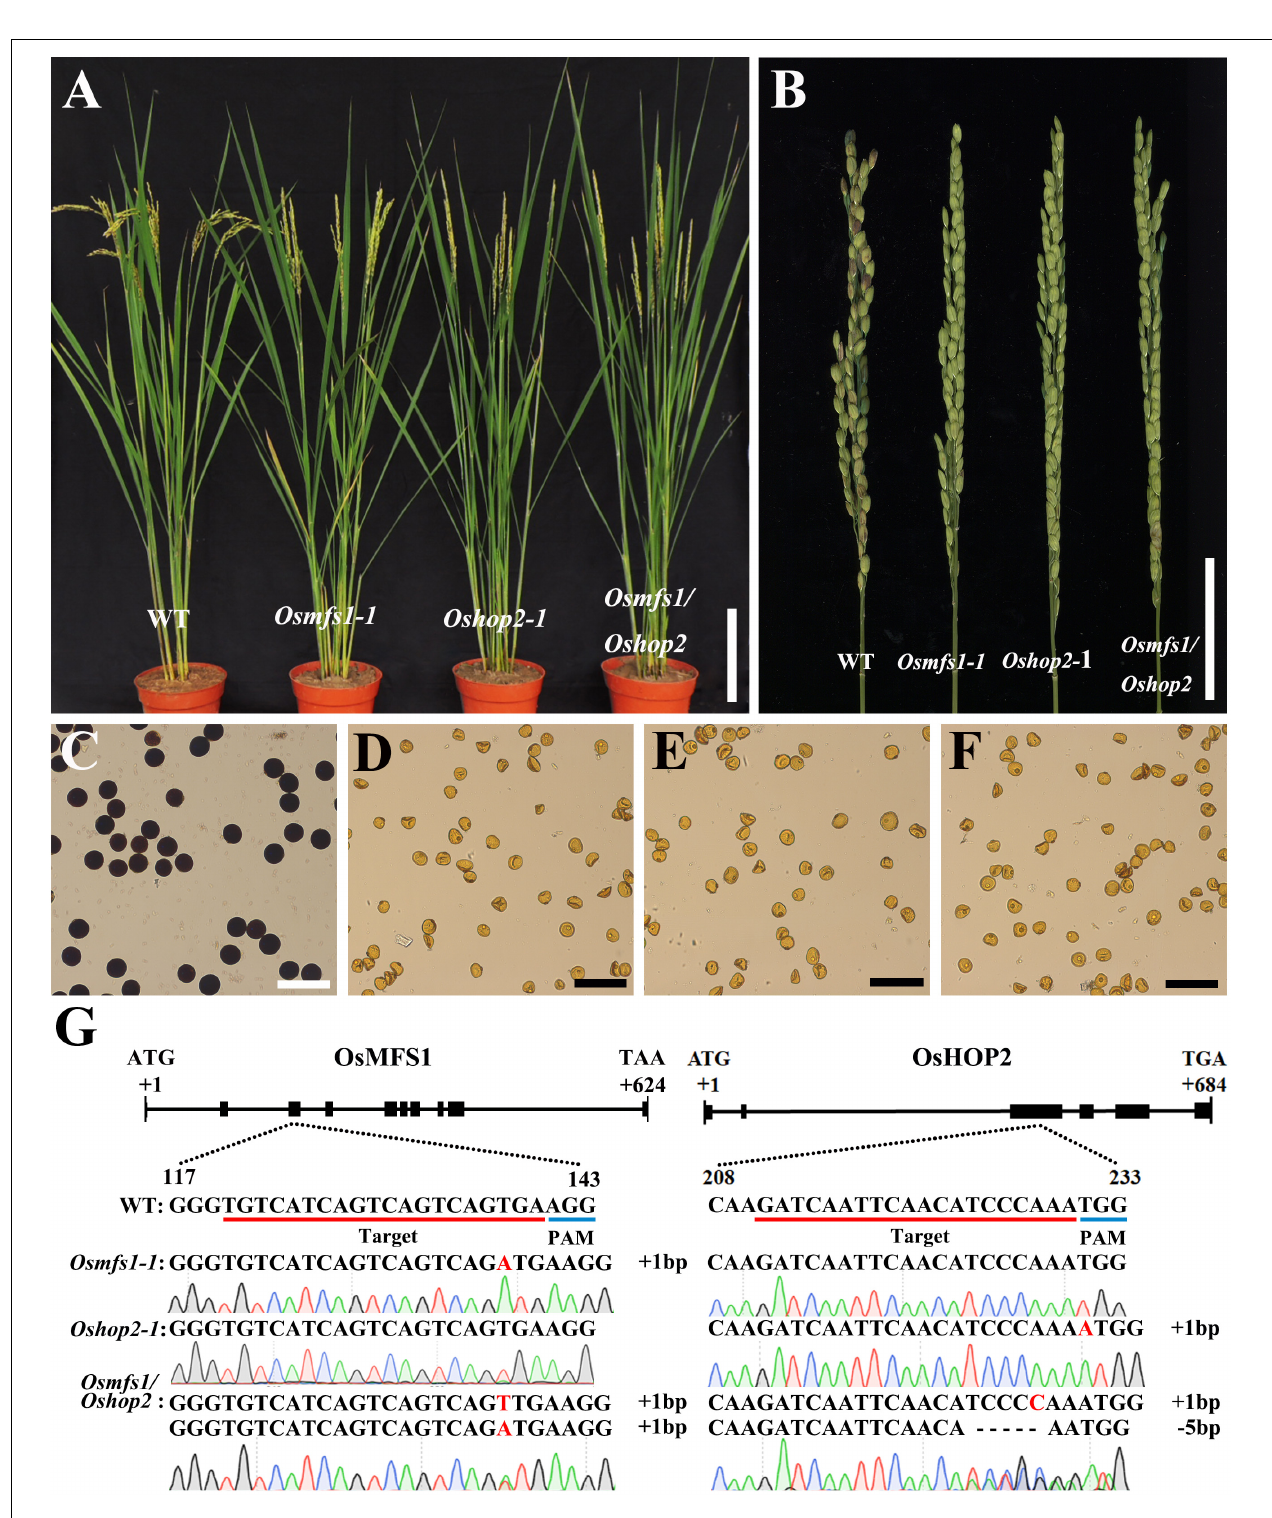
FIGURE 9 | Phenotype analysis of Osmfs1-1 , Oshop2-1 , Osmfs1 / Oshop2, and WT. (A) Comparison between a WT plant and an Osmfs1-1 plant, an Oshop2-1 plant, an Osmfs1 / Oshop2 plant at the heading stage. Bars = 10 cm. (B) Comparison of panicle between the WT and the Osmfs1-1 , the Oshop2-1 , the Osmfs1 / Oshop2 at the harvest stage. Bars = 4cm. (C) Viable pollen grains in a WT plant. (D–F) Inviable pollen grain in the Osmfs1-1 , Oshop2-1, and Osmfs1/Oshop2 . Bars = 100 µ m in panels (C–F) . (G) The schematic representations of the gene structure of OsMFS1 and OsHOP2 , the knockout sites of Osmfs1-1 , Oshop2-1 , Osmfs1/Oshop2 were verified by sequencing.